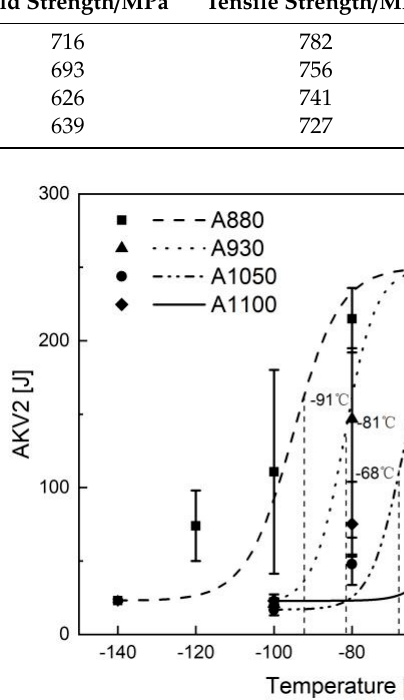
Materials 2020 , 13 , x FOR PEER REVIEW Figure 3. Impact absorbed energy as a function of temperature for di ff erent austenitizing temperatures. Figure 3. Impact absorbed energy as a function of temperature for different austenitizing temperatures.